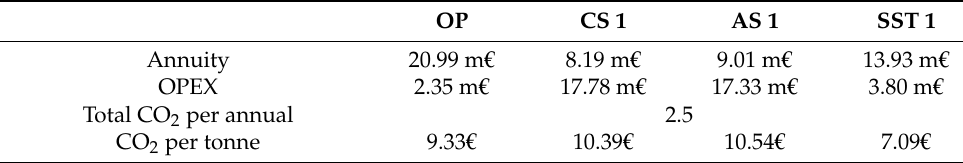
The cost of CO 2 per tonne calculations for the 180 km and 2.5 mtpa case are presented in Table A11. Table A11. Cost of CO 2 per tonne—180 km and 2.5